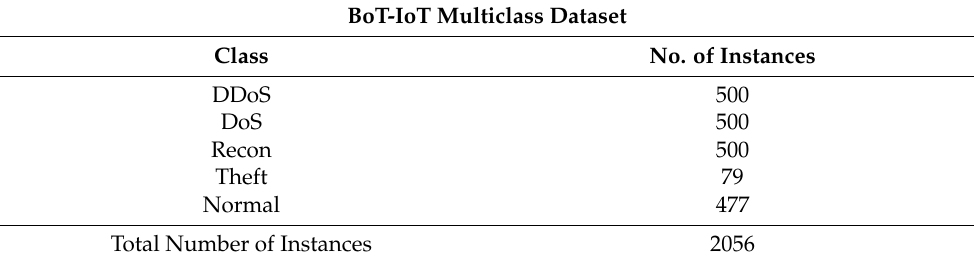
Table 2. Details of the multiclass dataset.